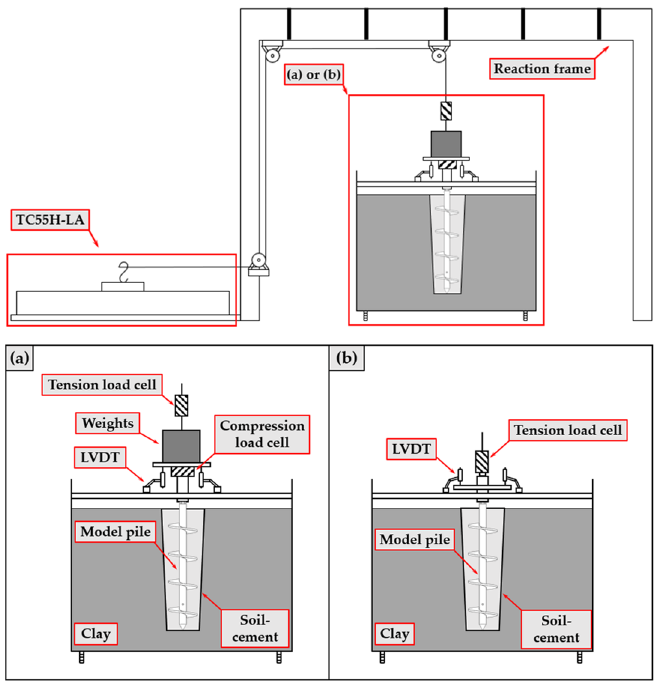
Figure 8. Loading tests: ( a ) compression loading, ( b ) uplift loading.